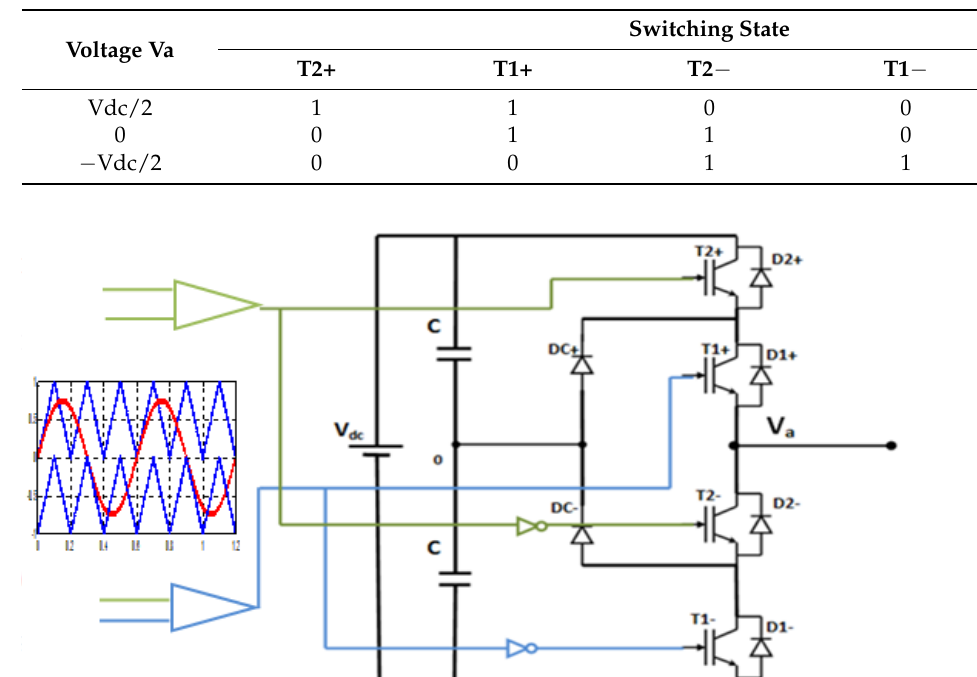
Figure 5. Structure of 3L_ NPC. Table 1. Basic switching of 3L_ NPC.